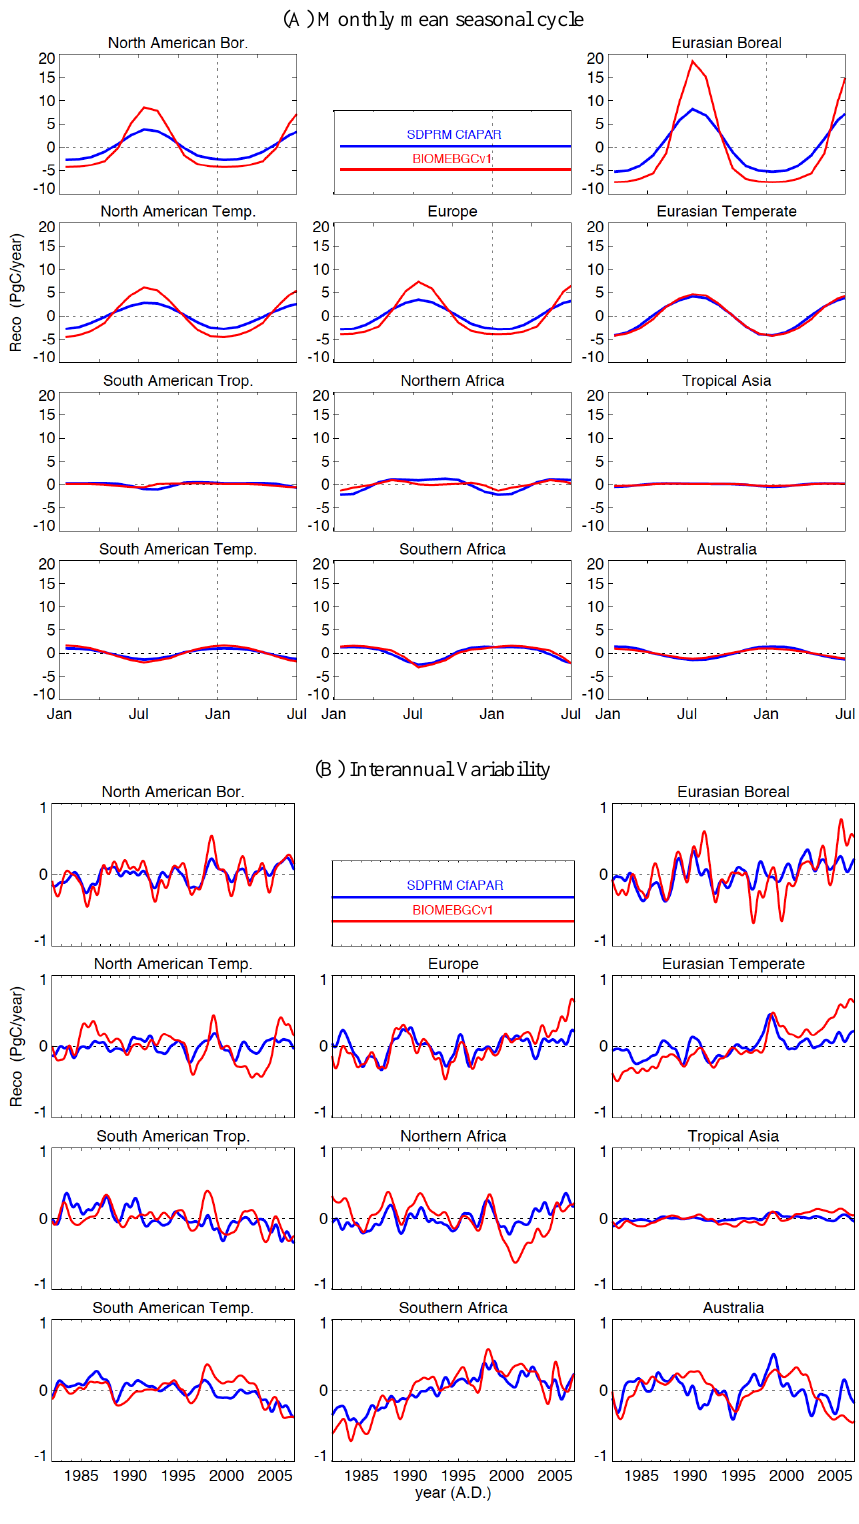
Fig. 9. The comparison between the estimated R eco from SDPRM-CfAPAR [Blue], and from BIOME-BGCv1 [Red] for the monthly mean seasonal cycle (A) and for the interannual variability (B) . The time series are integrated over 11 land regions (for the map of the regions see Fig. 3) and de-seasonalized and filtered for interannual variability (as in Rödenbeck